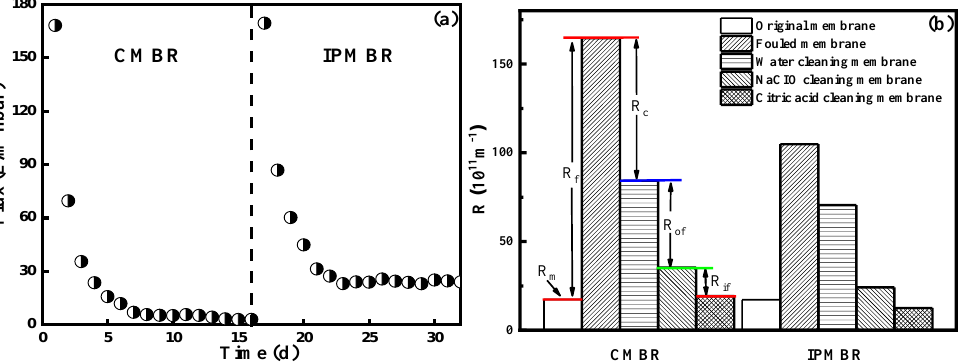
Figure 7 . ( a ) Time-variation of permeability on the membrane during the controlled MBR (CMBR) and immobilized photosynthetic bacteria MBR (IPMBR) operation and ( b ) filtration resistances calculated during the filtration with different PSB-MBRs.